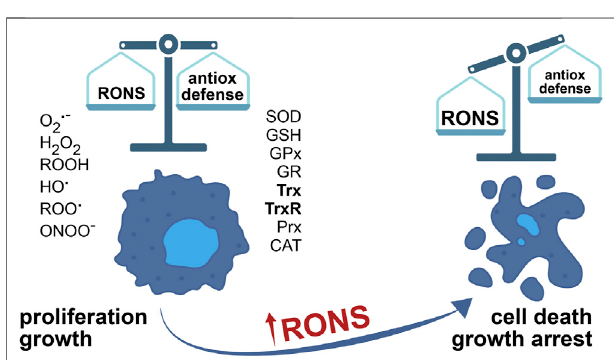
FIGURE 1 | The balance between RONS and the antioxidant defense system determines cell faith . The concentration of RONS is elevated in cancer cells, due to aberrant metabolism adjusted to accelerated growth and proliferation. To survive, cancer cells over-express enzymes of antioxidant defense. What ’ s more, RONS in cancer cells have an important part in tumor growth and promotion, in all stages of tumor development. However, further increase in RONS, by inhibition of the antioxidant detoxi fi cation systems, for example, causes cell death and inhibits tumor